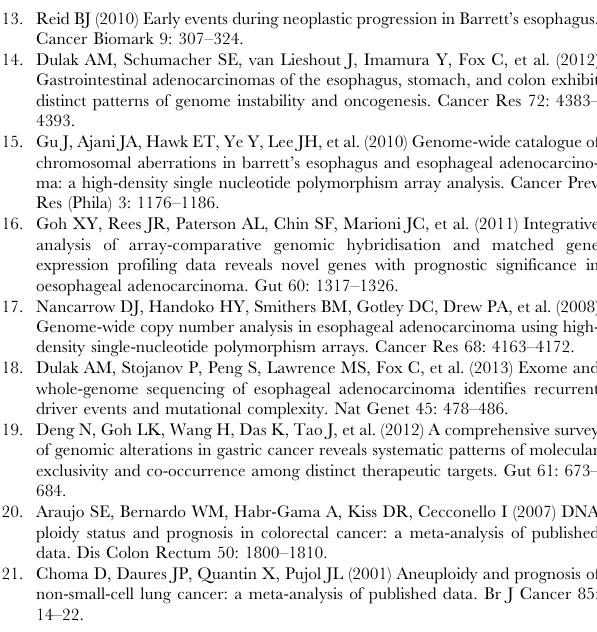
Table S1 Clinical and Pathologic Data for All Tumors. Table S2 Estimated Segmental Copy Number for Each Tumor in Chromosomal Segments with Abnormal Copy Number in at Least One Tumor. Table S3 Regions with Copy Number Gain (CN . 3.025) in Three or More Tumors. Table S4 Regions with Copy Number Loss (CN , 1.474) in Three or More Tumors. Table S5 Correlation of Contrast QC and QC Call Rate with Total CNA